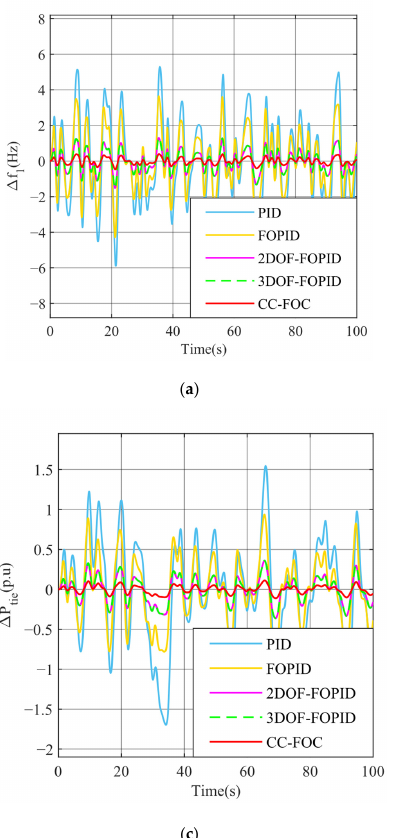
∆ P P Δ . Figure 8. The variation of ( a ) random wind speed V W W .